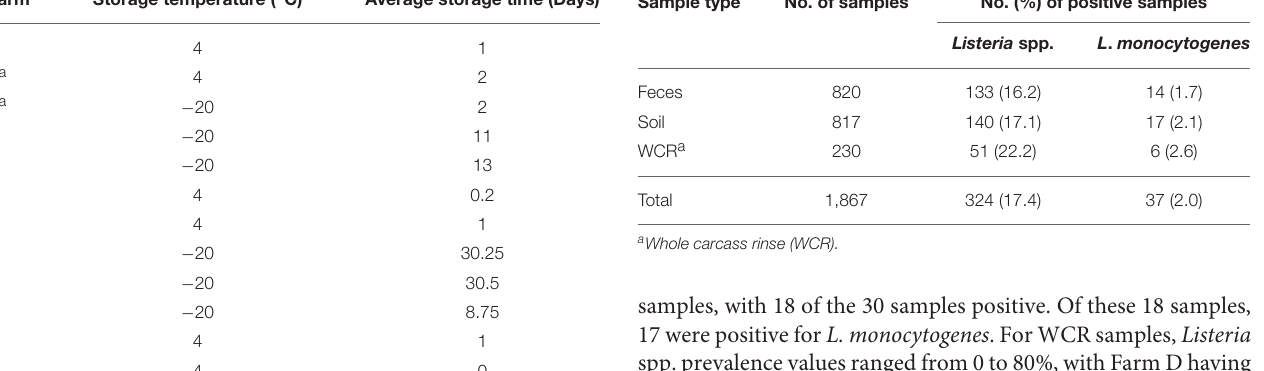
TABLE 4 | Effect of sample type on prevalence of Listeria spp. and Listeria monocytogenes in pastured poultry farm samples. Sample